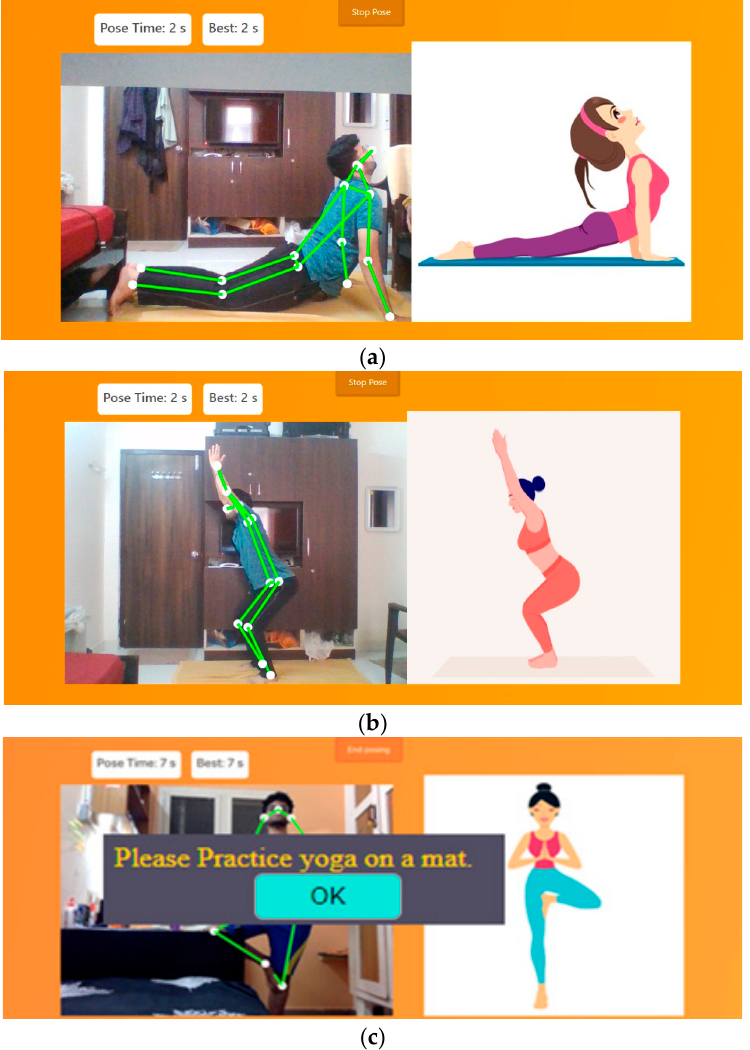
Figure 10. ( a ) Cobra pose recognition by Y_PN-MSSD model, ( b ) chair pose recognition by Y_PN- MSSD model, and ( c ) alert generated when a yoga mat is not recognized.